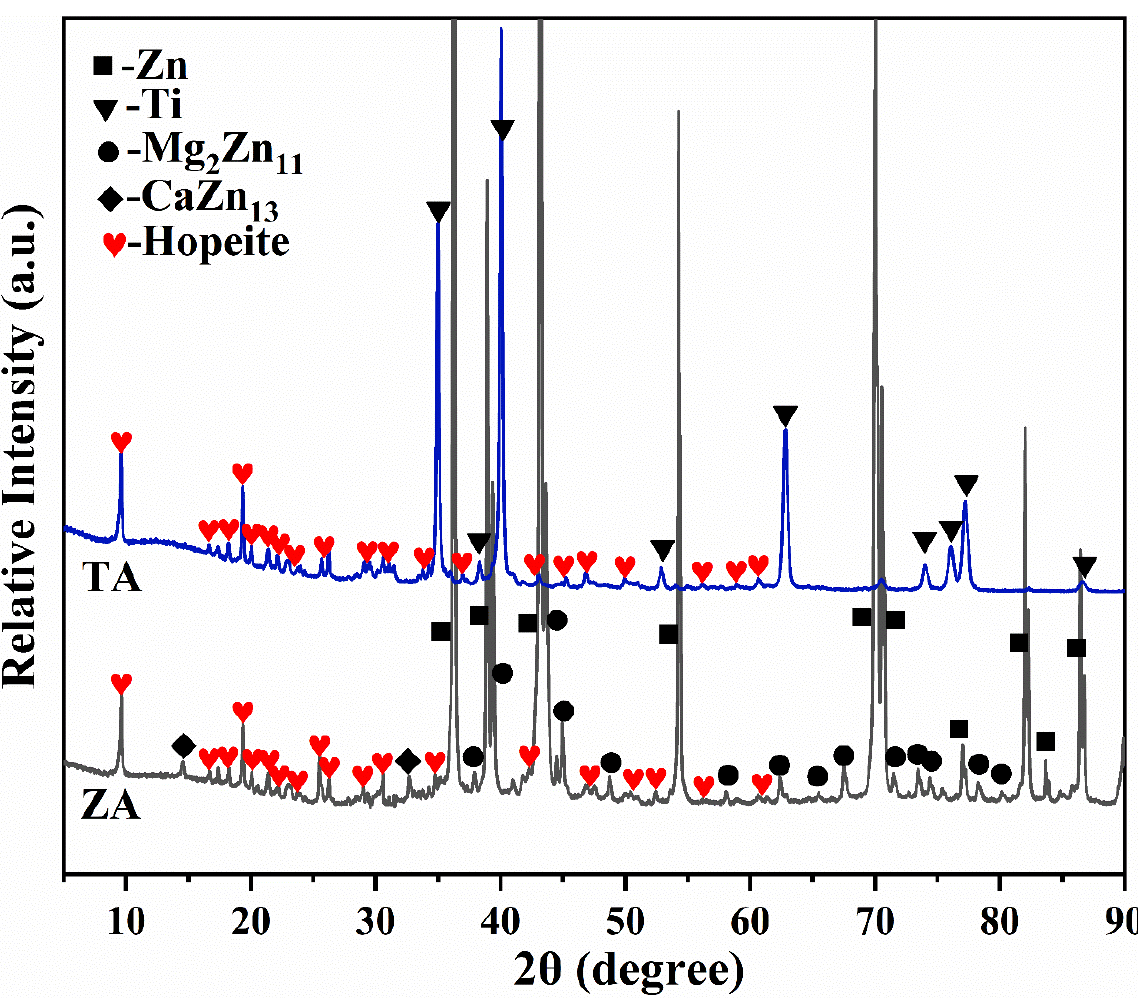
Figure 1. XRD patterns of the ZnP ‐ coated TA and ZA samples.